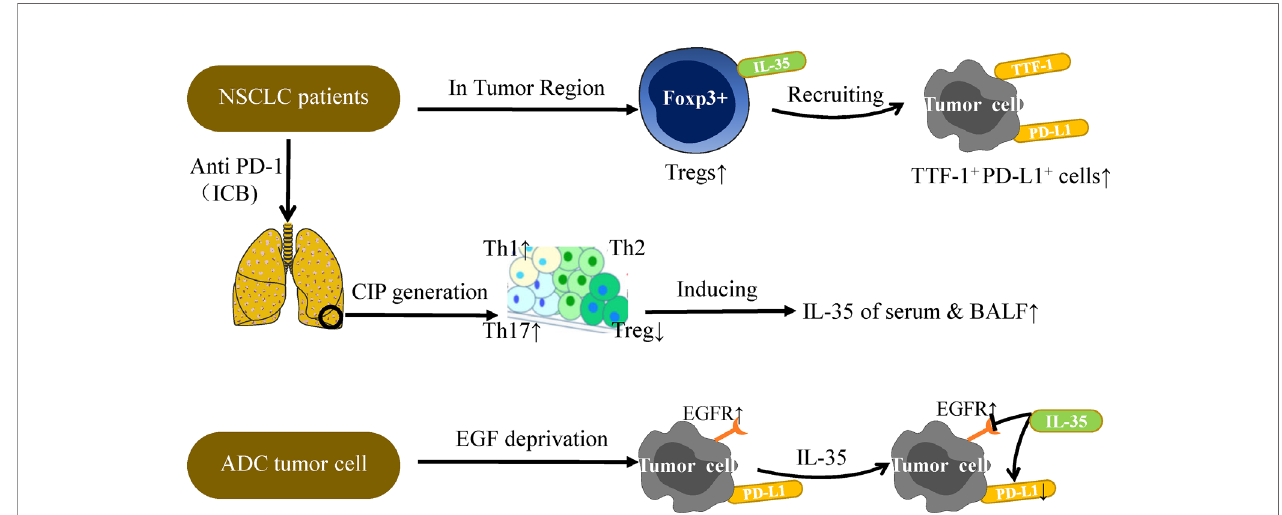
FIGURE 3 | IL-35 and PD-L1 in NSCLC immunotherapy. PD-L1 expression on tumor cells is the most studied biomarker in the context of predicting NSCLC patient immunotherapy outcomes. Further studies are needed to explore the relationship between IL-35 and PD-L1. Under conditions of EGF deprivation, IL-35 can reduce the expression of PD-L1 without impacting EGFR, which is also a target of NSCLC immunotherapy. A positive correlation between IL-35 + Tregs and TTF-1 + PD-L1 + cells has been observed in the TU region, and TTF-1 is a good prognostic factor associated with survival in NSCLC. In addition, CIP generation is often observed in patients undergoing PD-1 or PD-L1 antibody therapy. CIP patients have higher mean amounts of Th1 and Th17 cells and lower levels of Tregs in serum as compared to normal subjects, thus inducing IL-35 secretion in the plasma and BALF. The levels of IL-35 in the plasma and BALF can be measured for the diagnostic evaluation of CIP patients. Overall, the complex relationship between IL-35 and PD-L1 must be considered when discussing the potential role of IL-35 in tumor